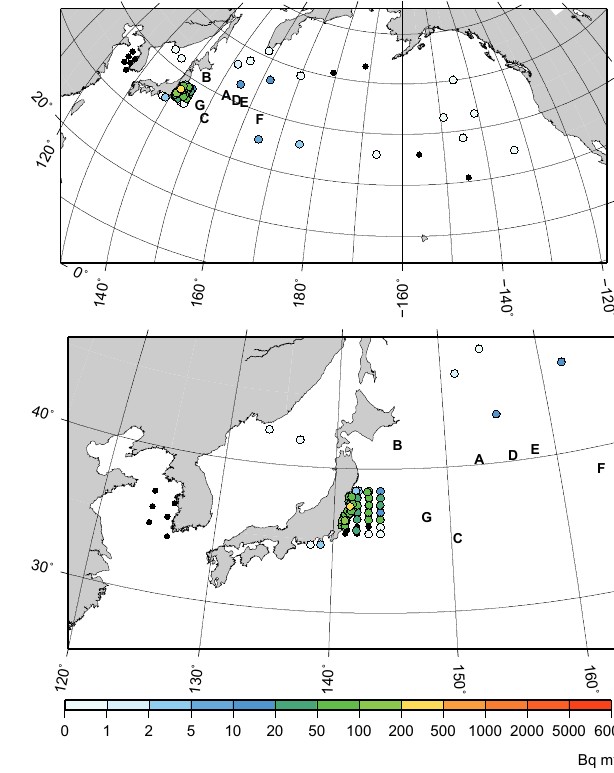
Fig. 1. 134 Cs activity in the surface water during the period from April 2011 to June 2011 for the North Pacific Ocean (upper) and close to Japan (lower). Positions of Argo floats on 15 May 2011 are marked “A–G”.